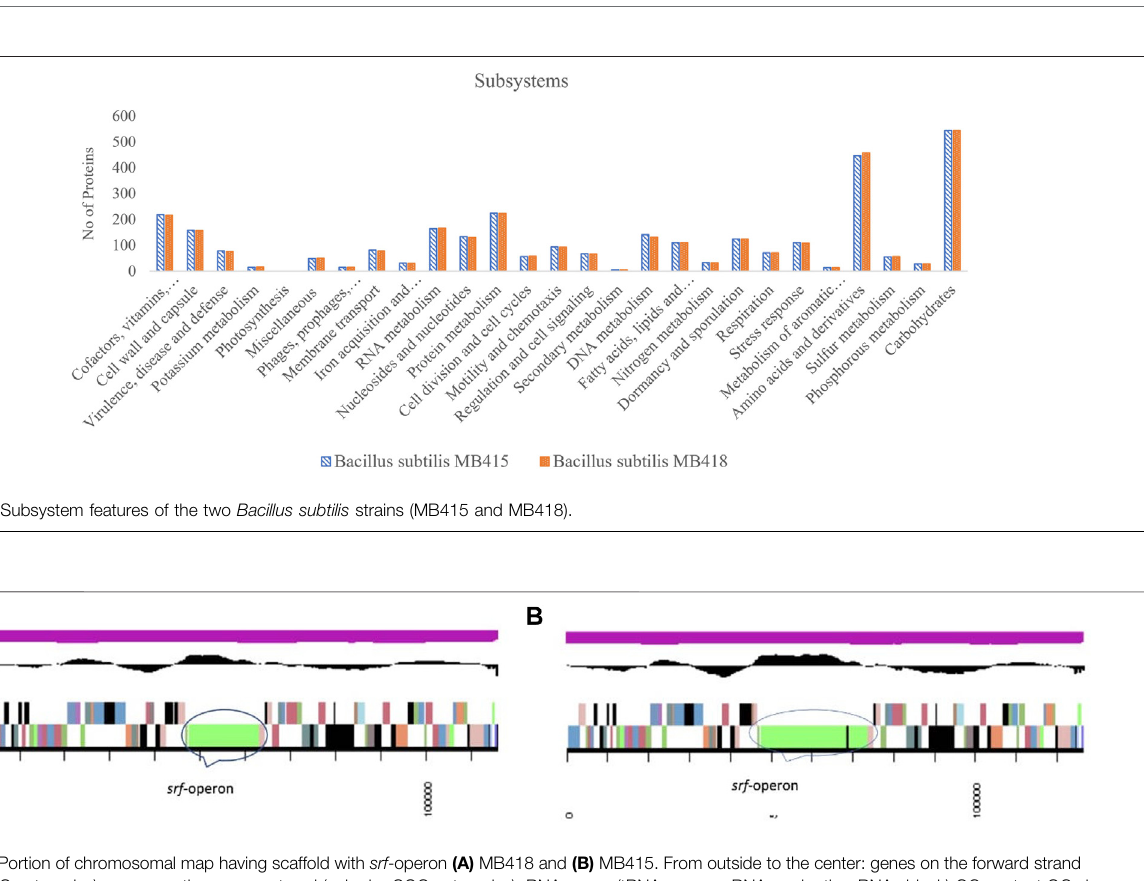
FIGURE 3 | Portion of chromosomal map having scaffold with srf -operon (A) MB418 and (B) MB415. From outside to the center: genes on the forward strand (color by COG categories), genes on the reverse strand (color by COG categories), RNA genes (tRNAs green, rRNAs red, other RNAs black) GC content GC